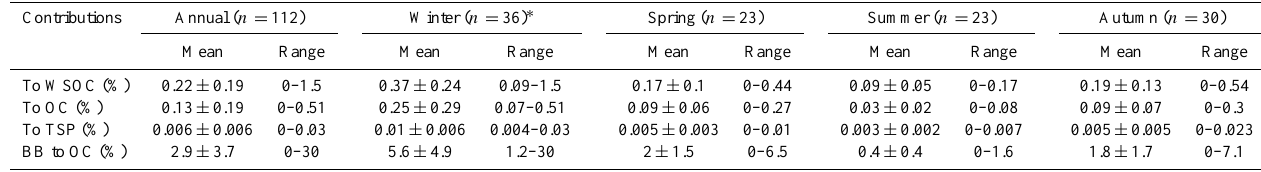
Table 4. Annual and seasonal means of contributions of total carbon in the anhydrosugars to the WSOC and OC, of the total anhydrosugar mass to the TSP and of biomass burning (BB) to the